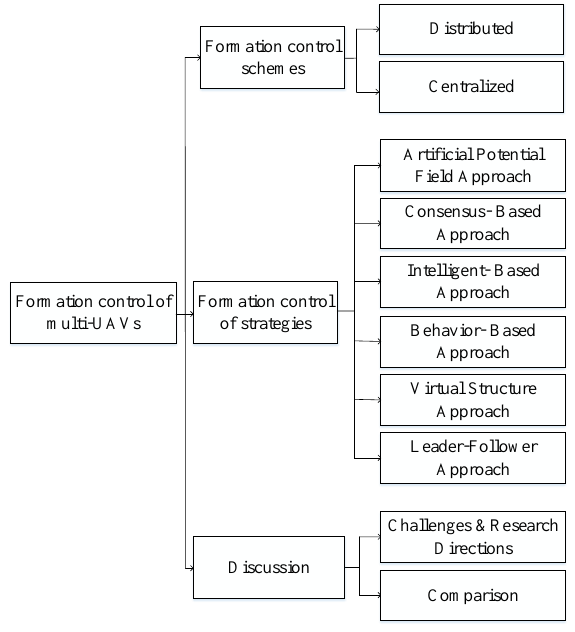
Figure 1. Formation Control of Multil-UAVs